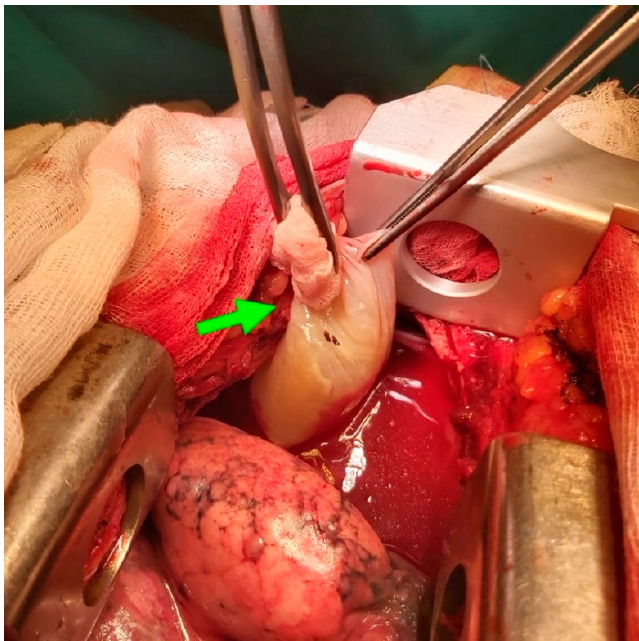
Figure 5. Intraoperatively a perforated bulla (green arrow) was found at the right middle lobe and was treated with bullectomy and talc pleurodesis.